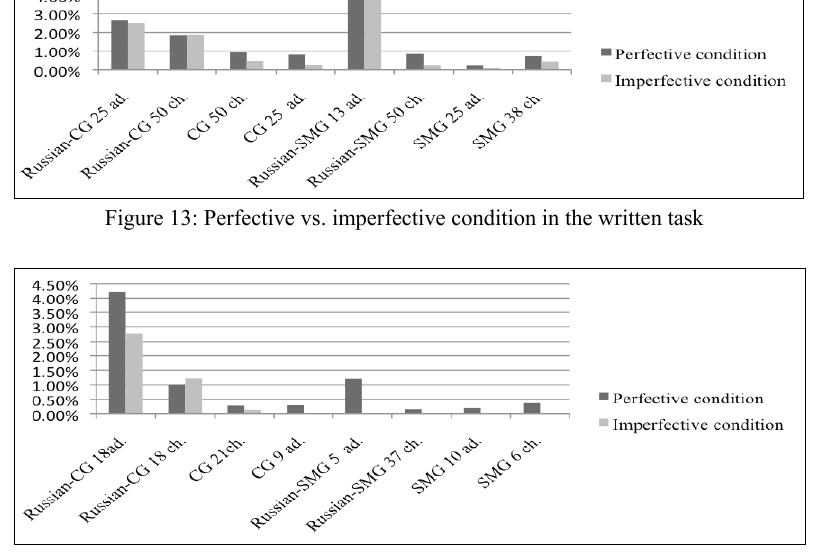
Figure 14: Perfective vs. imperfective condition in the oral